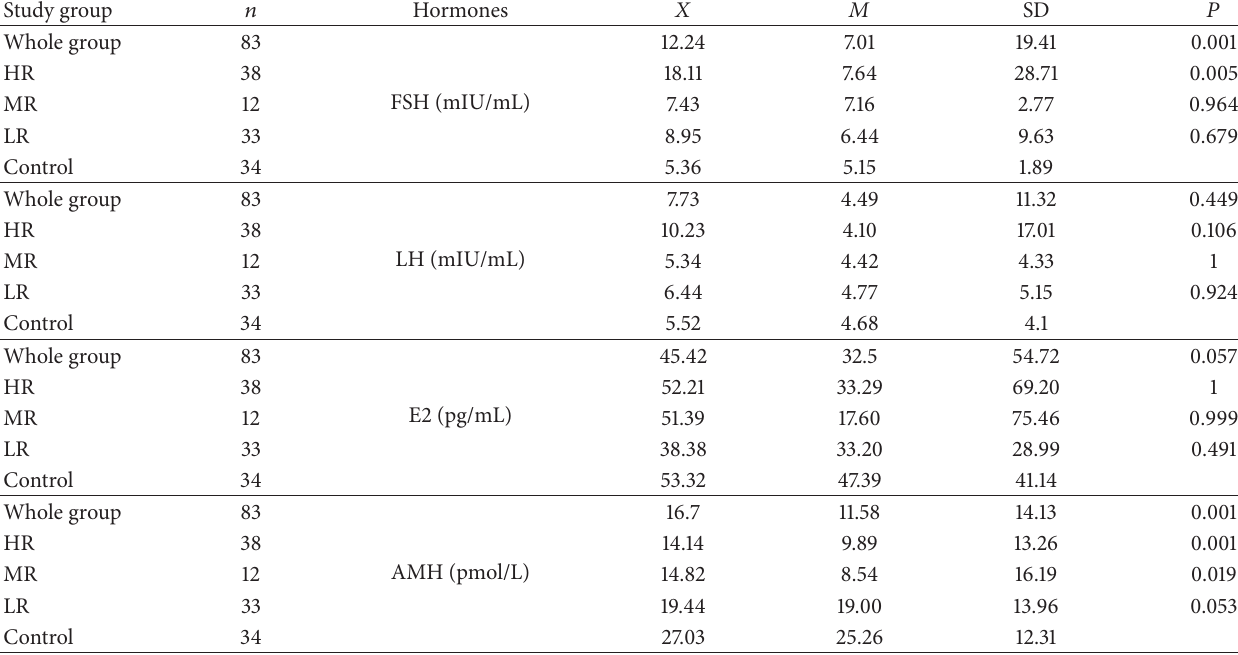
Table 2: Serum levels of FSH, LH, E2, and AMH in female cancer survivors according to risk groups and comparison to control group.